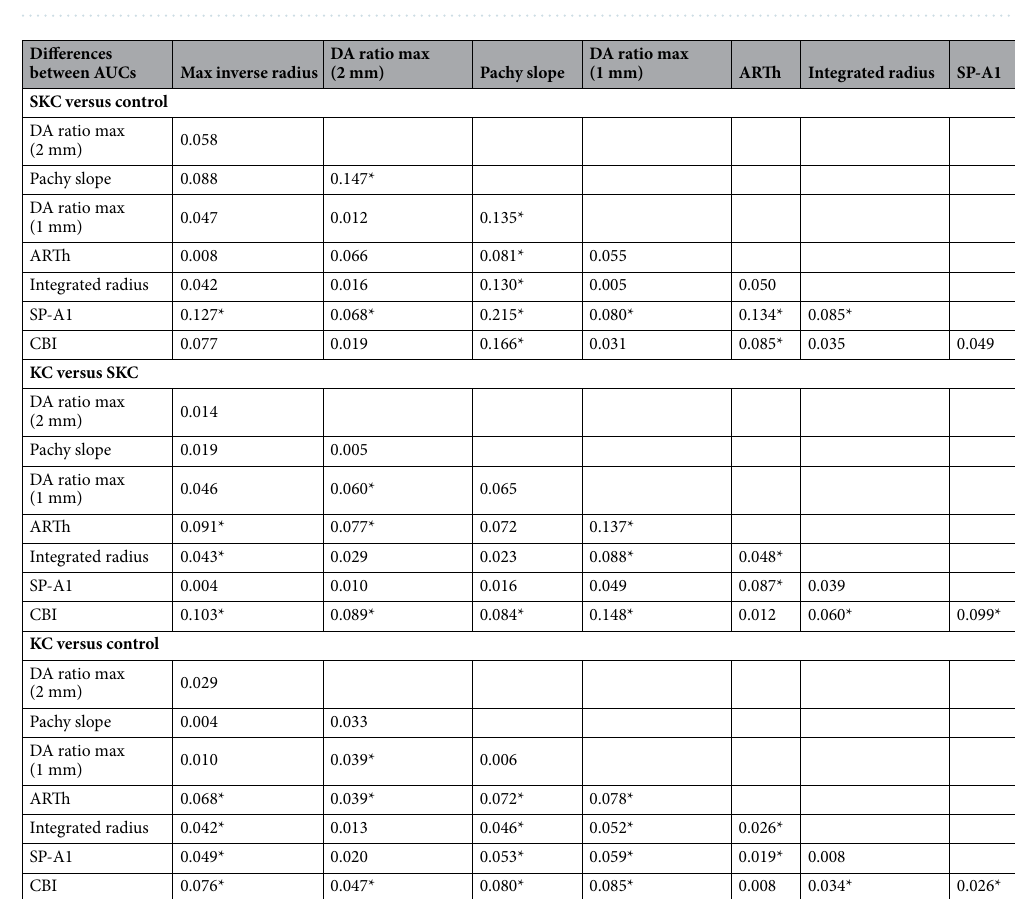
Figure 3. ROC comparisons of ARTh, integrated radius, SP-A1, and CBI in distinguishing SKC and KC eyes. ( A ) SKC versus control; ( B ) KC versus SKC; ( C ) KC versus control.